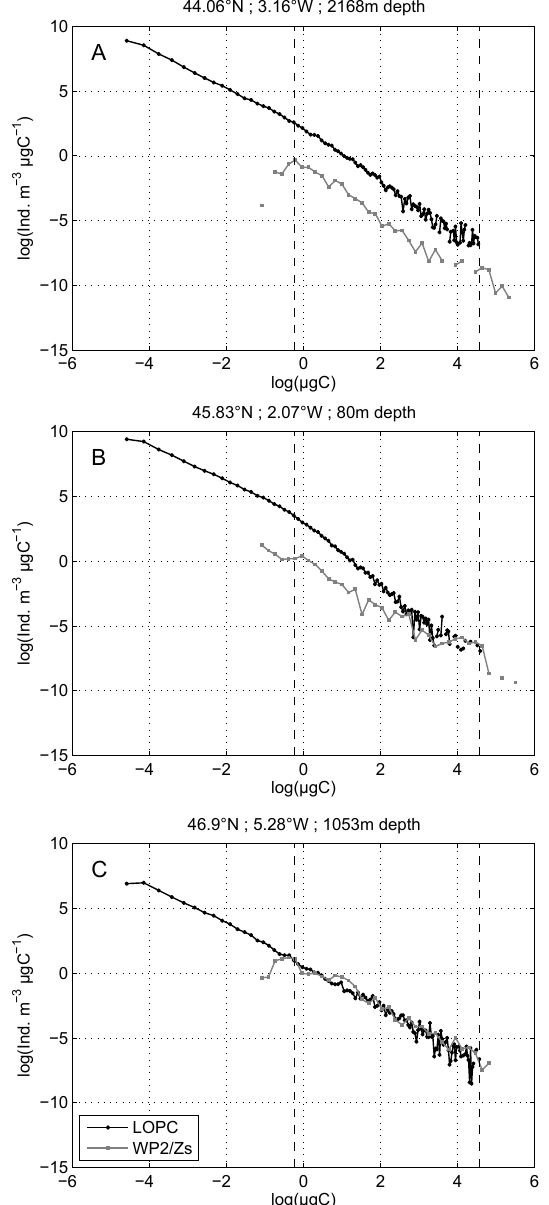
Figure 2. Examples of simultaneous number normalized size spec- tra (NNSS) measured by the LOPC (black lines) and by the WP2/Zs validated zooplankton (grey lines). The two vertical dashed lines in- dicate the limits of comparable size classes. Geographic coordinates and bottom depth are indicated. (a) shows an example where the LOPC overestimates the WP2/Zs for all size classes, (b) where the overestimation is only for smaller size classes and (c) where there is no visible overestimation.